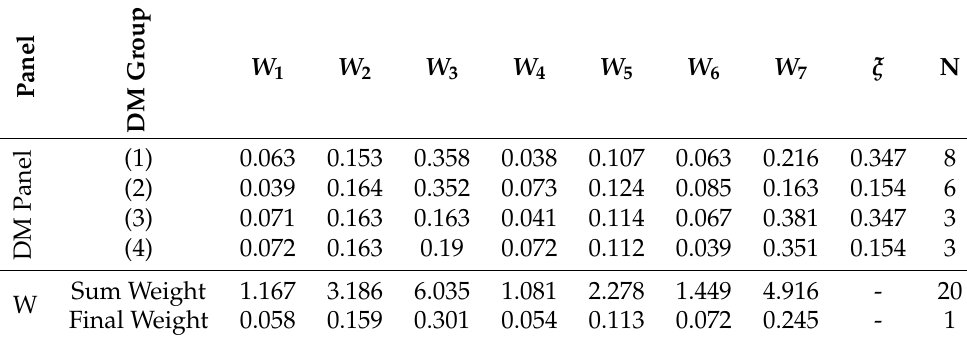
Figure 4. Weights of the criteria for each DM group. The calculated value of ξ for each group is 0.347, 0.154, 0.347, and 0.154, respectively (see Table 4). Furthermore, to find the consistency ratio in all groups, we have a BW = 9, then, the consistency index for each of the groups is 5.23 (see Table 1). The consistency = 0.066. Similarly, the calculated consistency ratios for ratio for the first group is 0.347 5.23 other groups are 0.029, 0.066, 0.029, and 0.066, respectively. It is obvious that the calculated consistency ratio obtained for each group of decision makers is less than 0.1, which indicates that the output results are highly consistent. Table 4. Weight of the